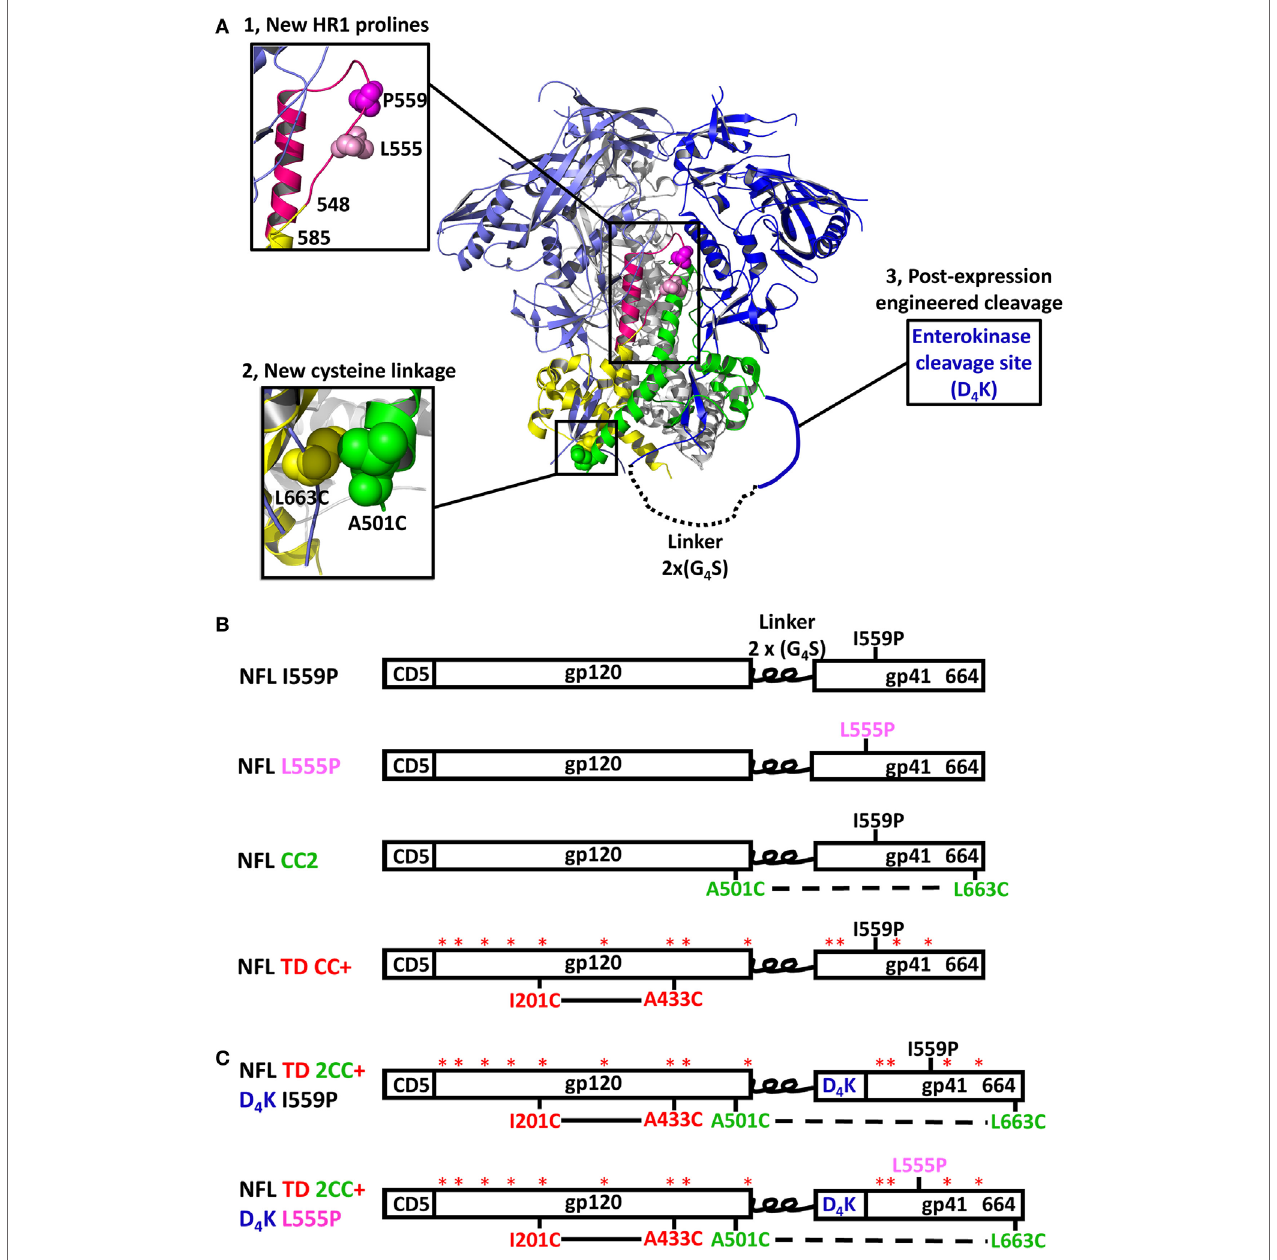
FigUre 1 | Design and schematic representation of HIV-1 Env NFL trimers. (a) Schematic depiction of the approaches used to redesign the NFL trimers using the available BG505 SOSIP.664 structure (PDB: 5CEZ). The trimer is shown in the ribbon representation with an inset of a closer view to illustrate selected approaches of NFL trimer redesign. The gp120 and gp41 in the first gp140 protomer are shown in light blue and yellow, in the second protomer in blue and green, and in the third protomer in gray. Proline substitutions screened in the gp41 heptad repeat 1 region (aa 548–585) are shown in the hot pink ribbon; the first protomer is shown in a close-up view (upper left). L555P is indicated with light pink spheres and I559P by the magenta spheres. The A501C-L663C cysteine pair forming a putative inter-protomer disulfide bond between the first and second protomers is shown in yellow and green spheres in the lower-left, close-up view. The engineered enterokinase (EK) cleavage site is shown as a solid blue line (upstream of the fusion peptide) to allow controlled post-expression cleavage. (B) Linear schematic diagram of the NFL with I559P or L555P, A501C-L663C (CC2), or TD CC + substitutions. (c) Linear schematic diagram of the NFL indicating favorable modifications and the engineered EK cleavage